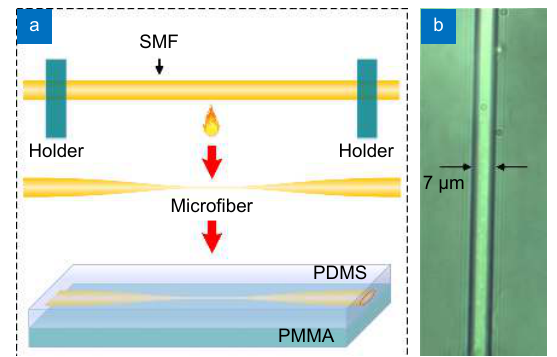
Fig. 1 | ( a ) Fabrication procedure of the microfiber-based ultrasound sensor. ( b ) Micrograph of the prepared